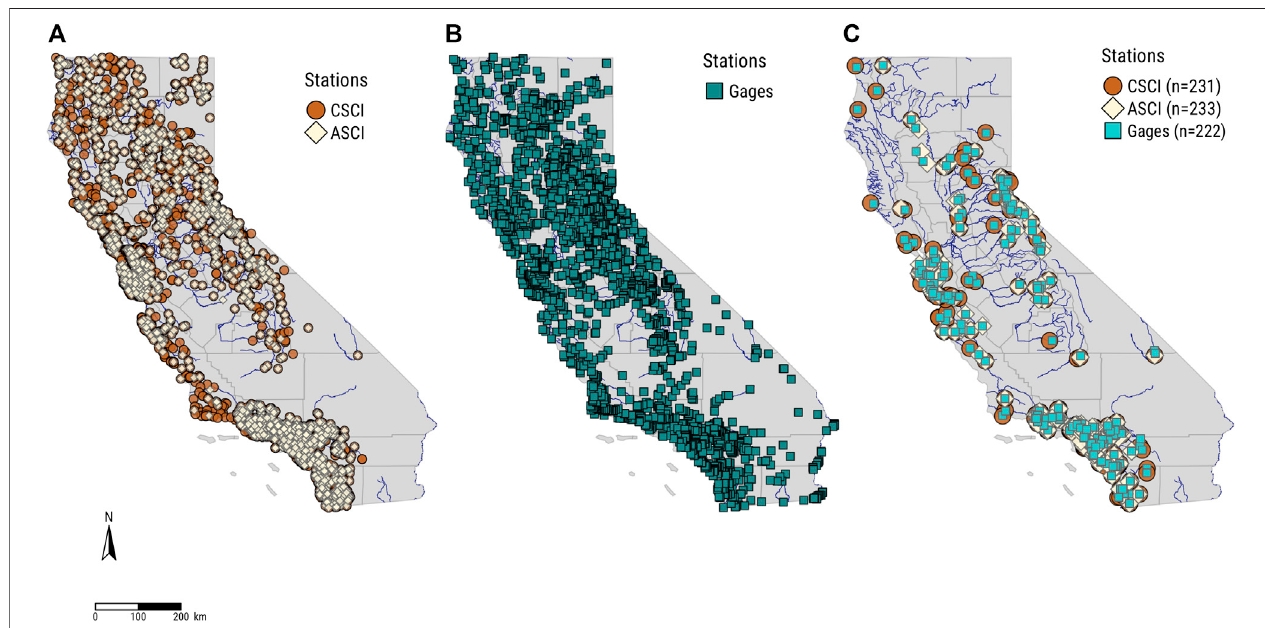
FIGURE2| MapsofCaliforniashowing (A) CSCI( n (cid:1) 2,935)andASCI( n (cid:1) 2,320)sites, (B) USGSgages( n (cid:1) 736),and (C) CSCI-USGS( n (cid:1) 231)andASCI-USGS ( n (cid:1) 233) site pairs with > 10 years of fl ow data. Note, some ASCI and CSCI sites paired with more than one USGS gage site.